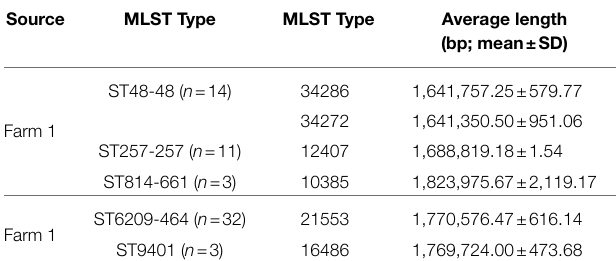
TABLE 1 | Average genome length per MLST and cgST